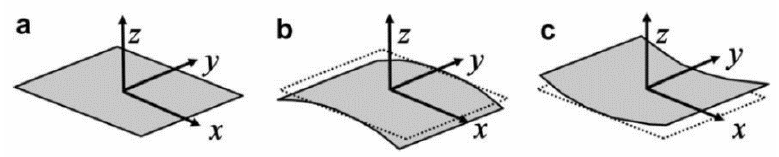
Figure 6. Bistable laminate ( a ) reference flat plate, ( b ) and ( c ) stable geometries [89].